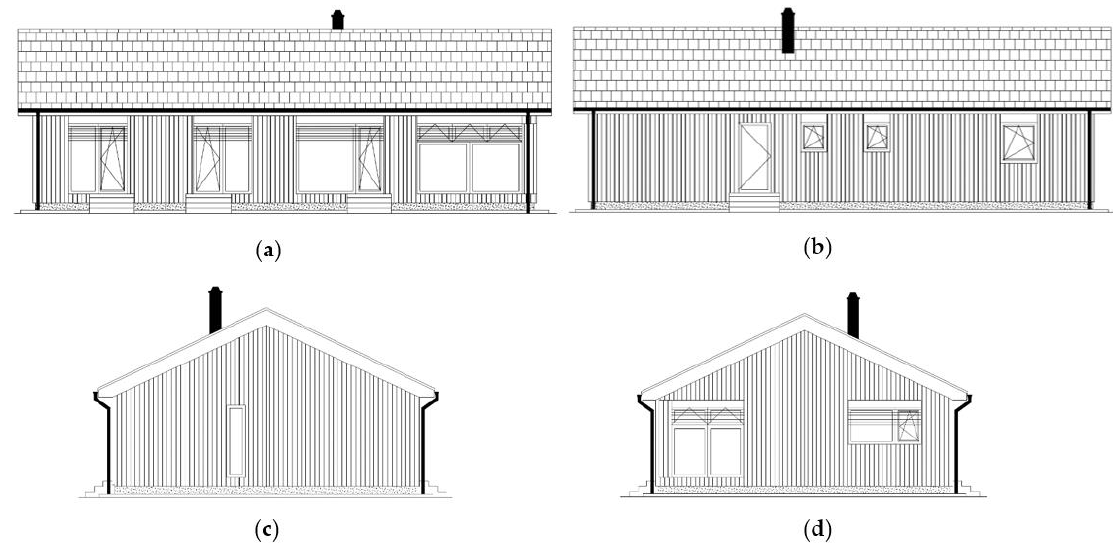
Figure 4. Front views of the construction: ( a ) western view; ( b ) eastern view; ( c ) northern view; and ( d ) southern view.